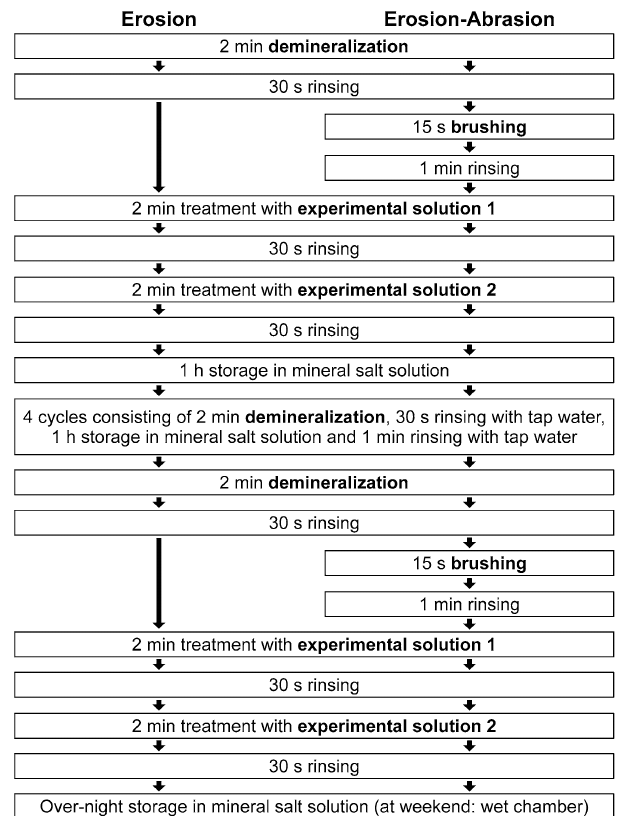
Figure 4. Flow chart of study procedures in each Experiment. Except for negative and positive control group, in experiment 1 samples were treated with biopolymers only, in experiment 2 samples were additionally treated with F/Sn. The two different biopolymers were always applied in two separate solutions; in experiment 2 the F/ Sn was applied together with chitosan. See Table 2 for experimental solutions used in the respective group and experiment.